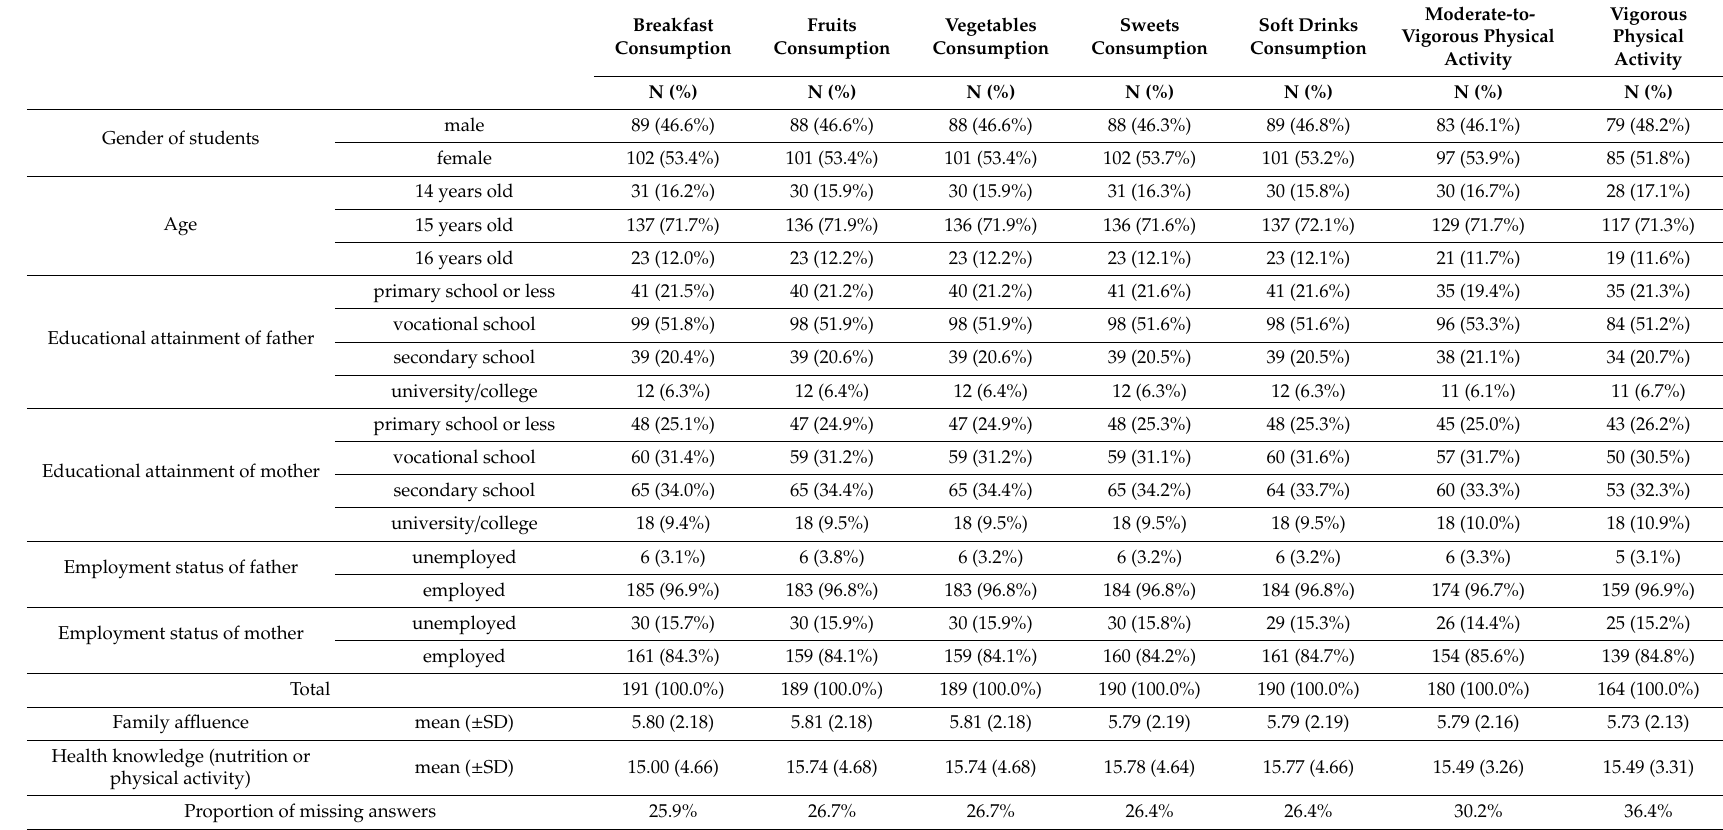
Table 2. Descriptive statistics: distribution of determinants for each outcome